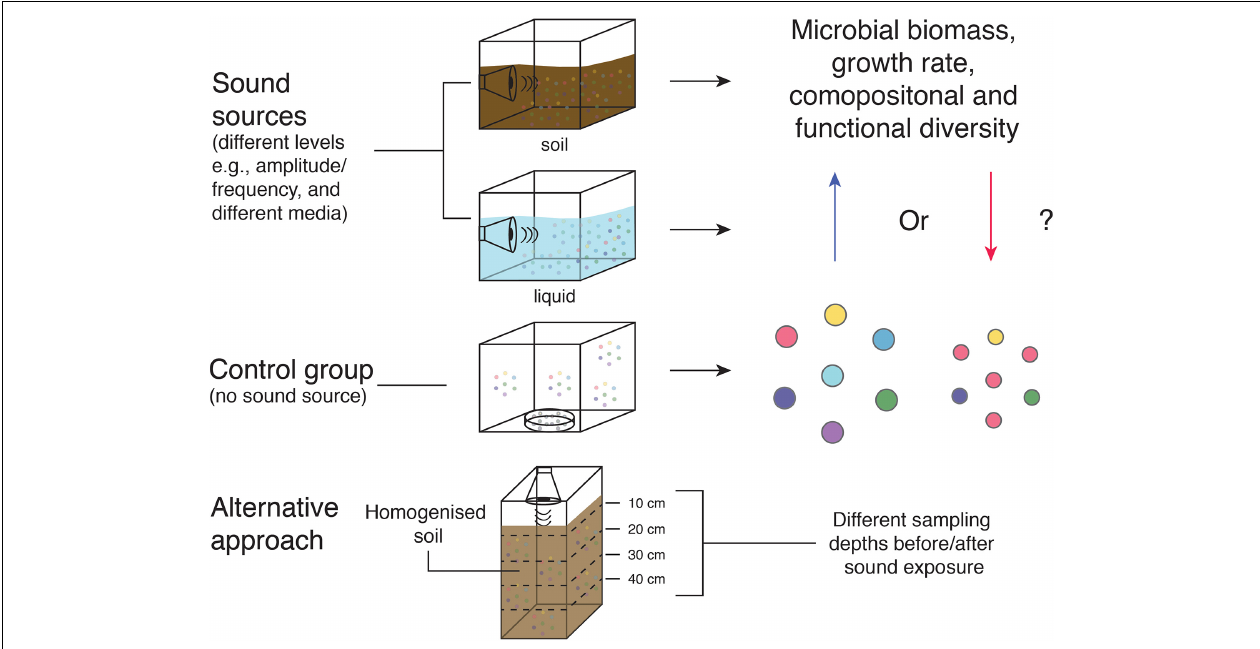
FIGURE 1 | Schematic of sound exposure experiments. Gu et al. (2016) investigated biomass and growth rate of a single taxa. However, similar experiments could be carried out to investigate potential changes in microbial community compositional and functional diversity, whilst testing different interfaces/media that may have an important effect on sound